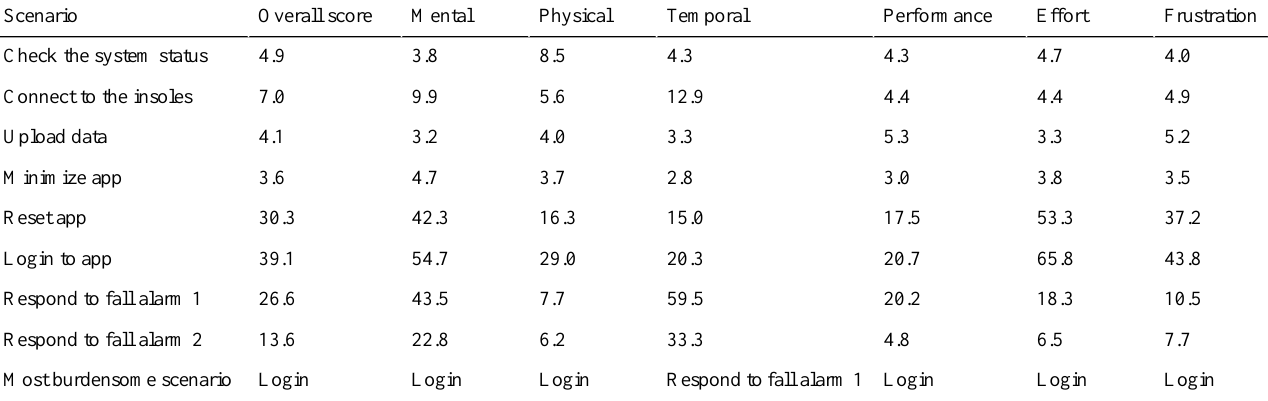
Table 14. NASA Task Load Index (NASA-TLX) scale breakdown by scenario. The NASA-TLX score ranges from 1-100, where 1=worst score possible and 100=best score